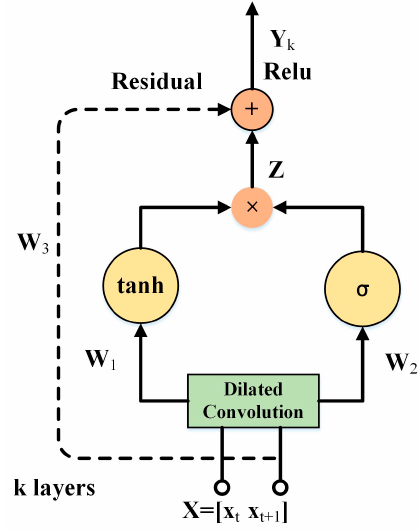
Figure 5. Diagram of residual dilated convolutional layer